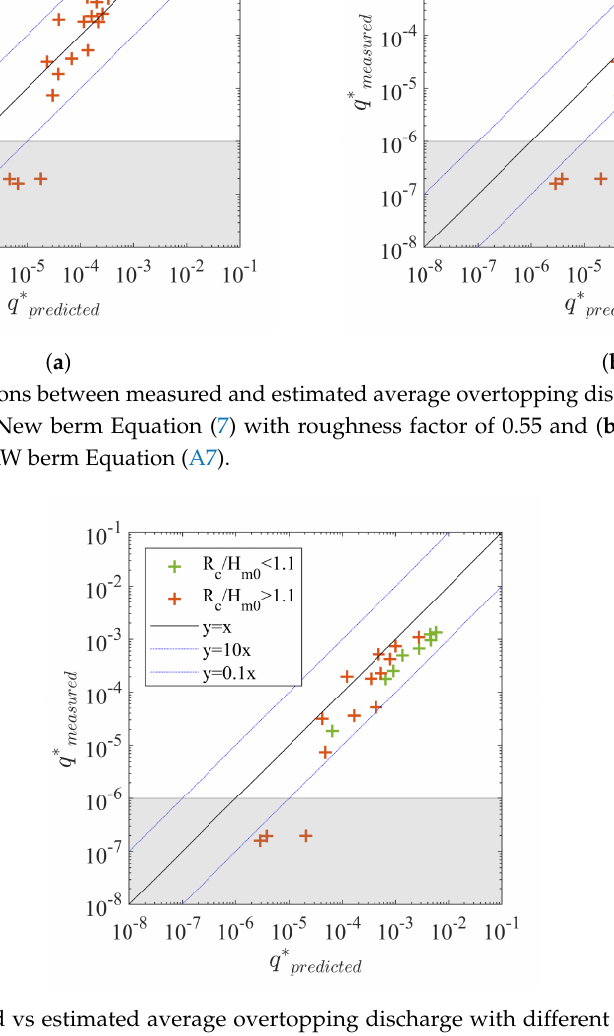
Figure 17. Measured vs estimated average overtopping discharge with different ranges of relative freeboard for Dataset